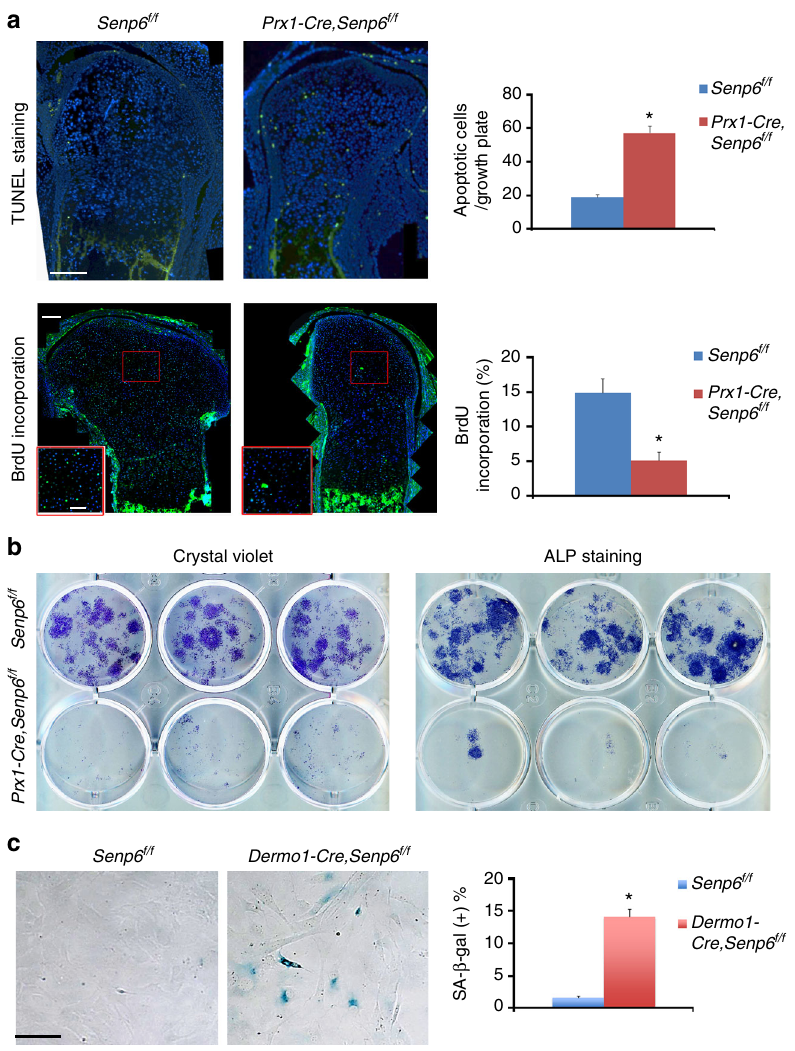
Fig. 2 Dysregulated OCP and chondrocyte homeostasis caused by Senp6 loss. a The growth plate of P0 Prx1-Cre;Senp6 f/f mice showed an enhanced apoptosis (upper panel) and decreased proliferation (lower panel). The red boxed regions were enlarged and are shown in the lower-right corner of each image. Scale bars = 100 μ m for growth plate and 50 μ m for the enlarged red boxes. Representative images are on the left and quanti fi cations on the right ( n = 3, error bars = standard deviation, * p < 0.05, Student ’ s t -test). b Prx1-Cre;Senp6 f/f bone marrow had a decreased number of CFU-F and CFU-O ( n = 3). c Rib chondrocytes cultured from Dermo1-Cre;Senp6 f/f mouse showed an augmented cell senescence (SA- β -gal staining); representative images are at the left and quanti fi cation at the right. Scale bar = 50 μ m; n = 3, error bars = standard deviation; * p < 0.05 relative to Senp6 f/f (control), Student ’ s t